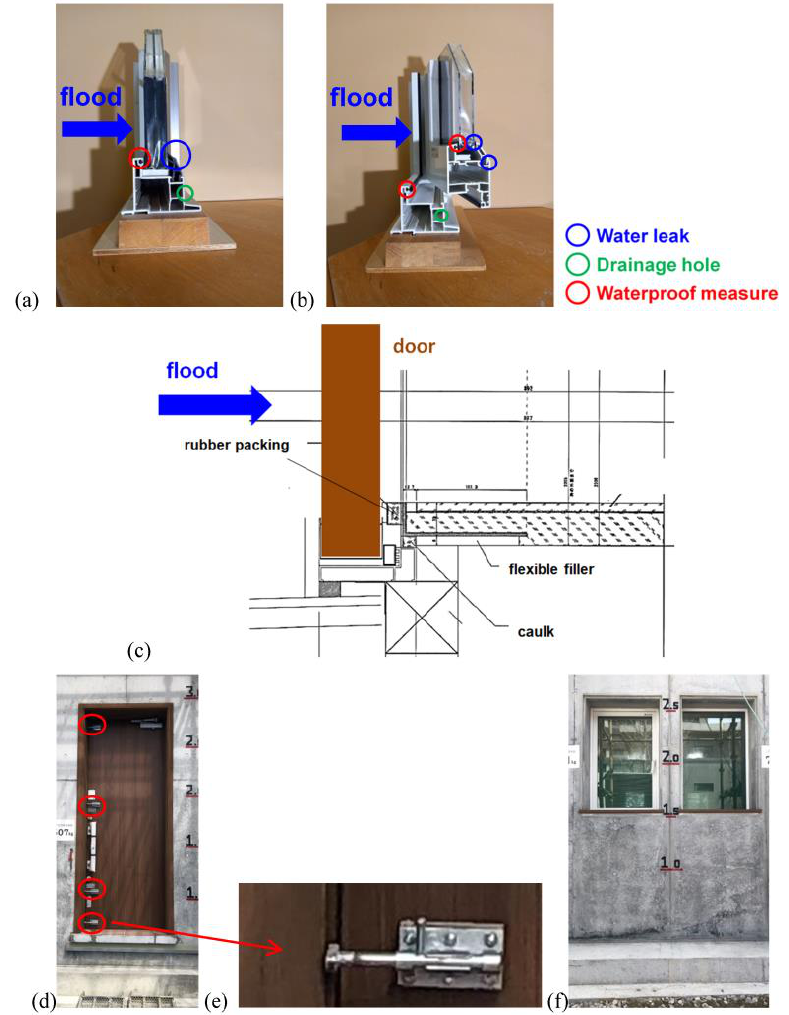
Figure 6. Waterproof measures: ( a ) fixed window, ( b ) operable window, ( c ) door sill, state after applying the waterproof measures ( d , e ) door and ( f ) west windows.